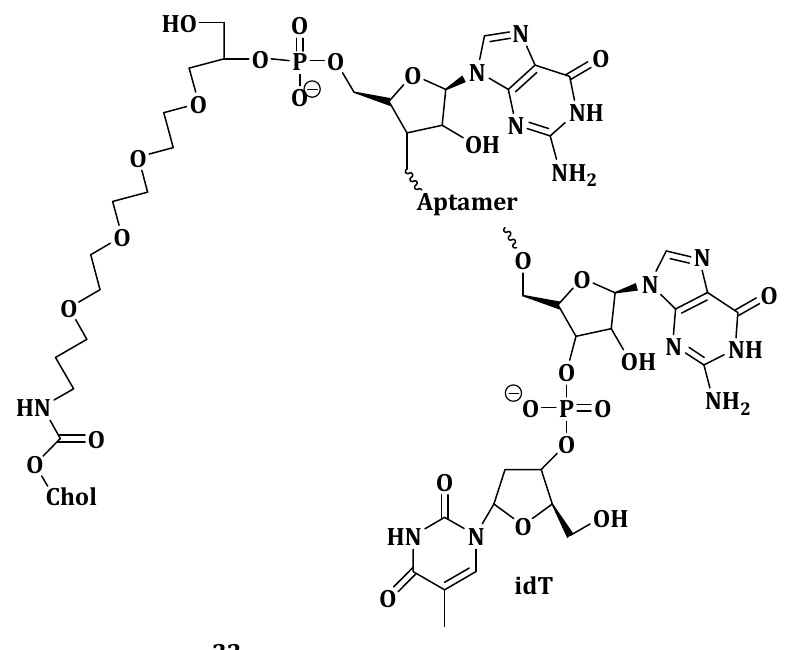
Figure 10. Structure of inverted d(T)-aptamer-Chol conjugate ( 22 ).